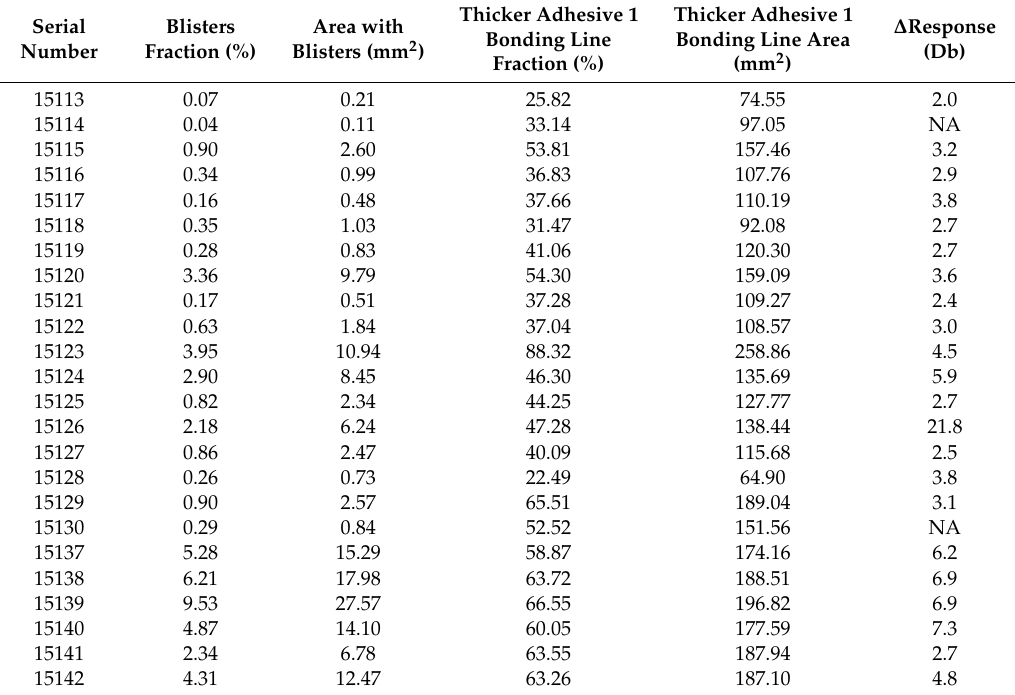
Table 1. Fraction of areas with blisters and thickness greater than 4 µ m for adhesive 1 layer. Not applicable (NA) values refer to samples that were scrapped before the pulse-echo